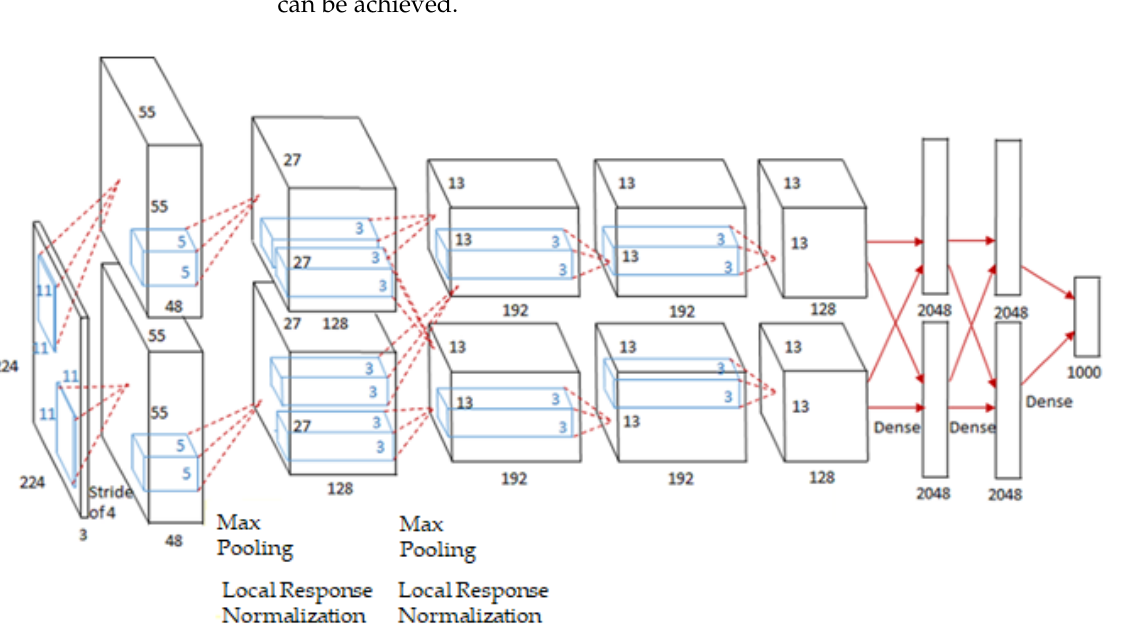
Figure 10. Basic AlexNet architecture. AlexNet achieved remarkable improvements in performance and applicability compared with the previously developed LeNet.